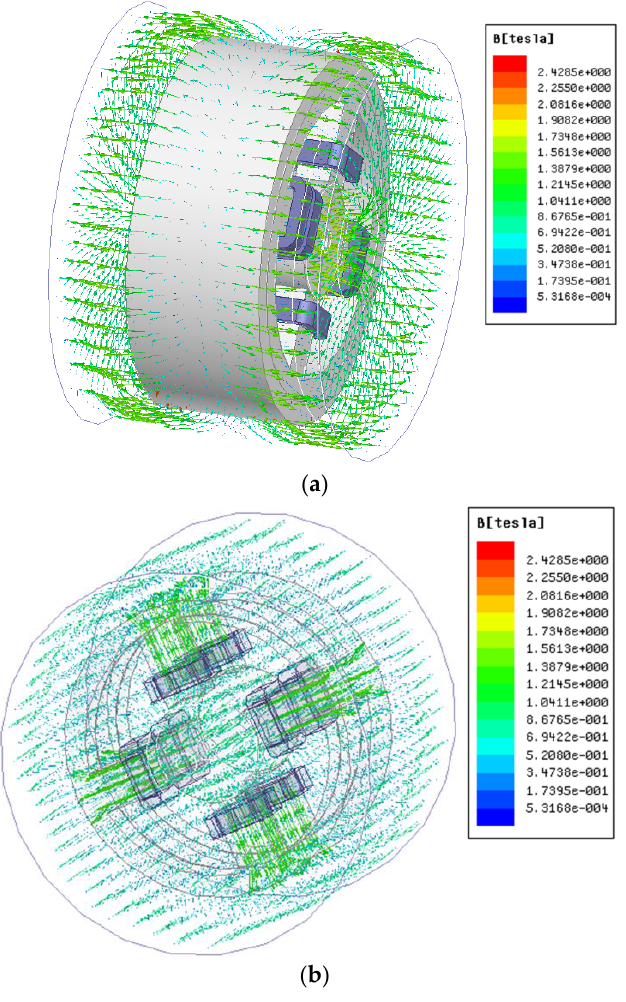
Figure 8. Flux density distribution of the PM ring. ( a ) Flux density distribution of PM ring in the outer stator; ( b ) flux density distribution of PM ring in the inner stator teeth.